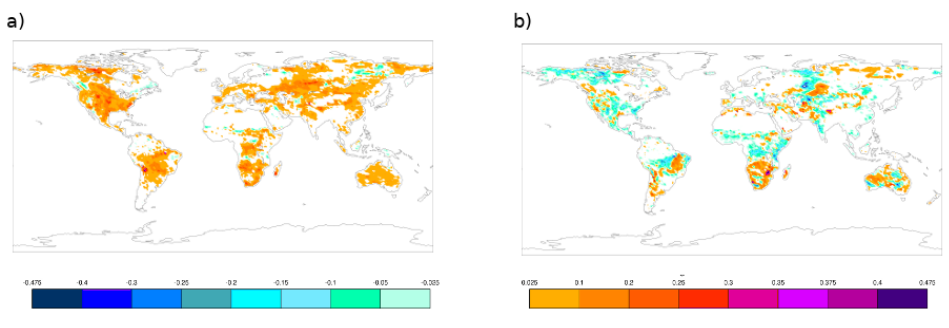
Figure 19. Difference in correlation with FluxCom energy fluxes between the 10-layers soil experiment (OSML10_TW) and the standard 4-layers experiment ( a ) Sensible heat flux; ( b ) Latent heat